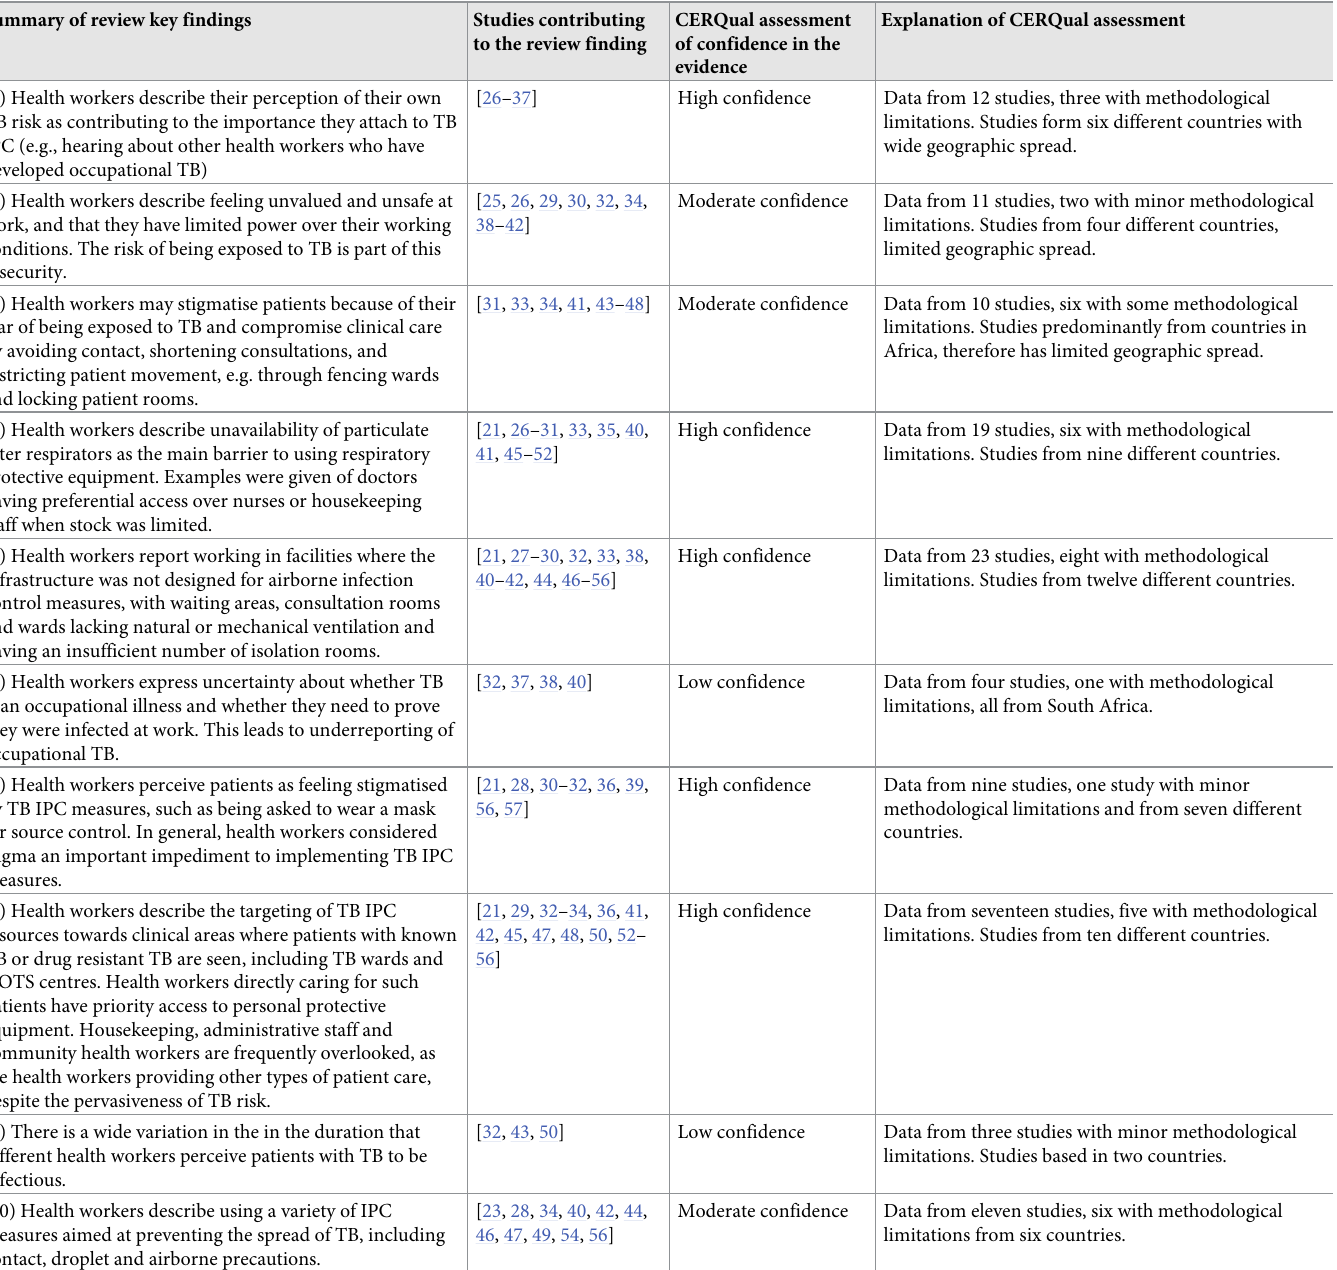
Table 2. Summary of ten key findings of qualitative evidence synthesis with CERQual